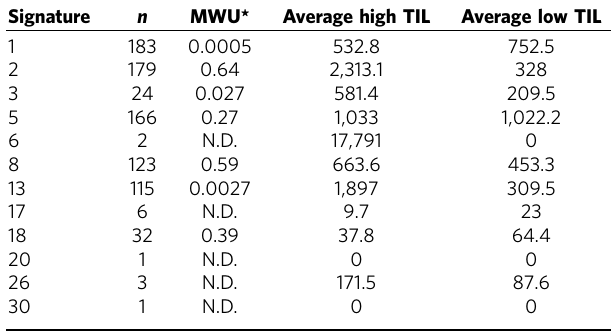
N denotes the number of samples with 4 0 of a particular substitution signature. The average number of substitutions is listed per TIL-signature group; high TIL indicates the top quartile of samples, low TIL the rest of the samples. * P value of